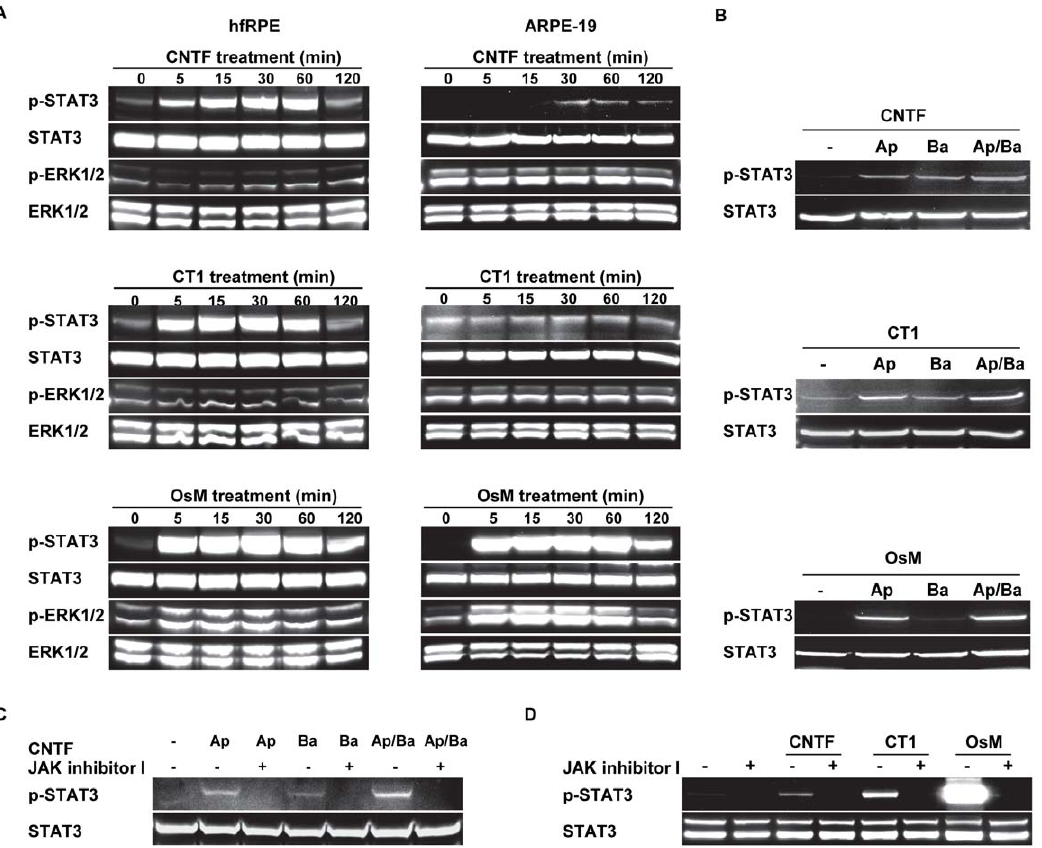
Figure 6. CNTF, CT1, and OsM induced activation of STAT3 and ERK1/2 in human RPE. A. Primary cultures of hfRPE and ARPE-19 were treated with CNTF, CT1, or OsM for a series of time points and the phosphorylation level of STAT3 and ERK1/2 were determined by Western blot analysis. B. CNTF, CT1, and OsM were added to the apical (Ap), basolateral (Ba), or both apical and basolateral (Ap/Ba) sides of confluent monolayers of hfRPE cells cultured on transwells for 30 minutes and phosphorylation levels of STAT3 were detected. C. Effects of JAK inhibitor I on CNTF induced phosphorylation of STAT3. Confluent monolayers of hfRPE cells were left untreated or treated with JAK inhibitor I (5 m M; both apical and basal sides) for 1 hour; 50 ng/ml of CNTF was added to the apical, basolateral, or both apical and basolateral side. Representative images from three separate experiments using cells from different donors. D. Effects of JAK inhibitor I on CNTF, CT1 and OsM induced phosphorylation of STAT3. Confluent monolayers of hfRPE cells were untreated or treated with JAK inhibitor I (5 m M; both sides) for 1 hour. 10 ng/ml of CNTF, CT1 or OsM was added to both apical and basolateral side and the phosphorylation levels of STAT3 were detected.